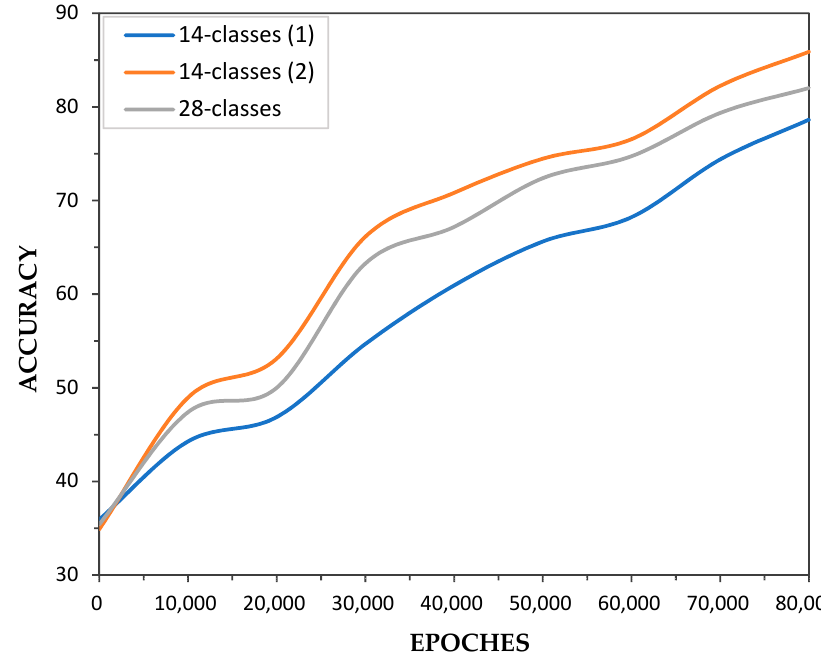
Figure 6. The accuracy curve of our method for 14-classes and 28-classes in the DHGD dataset. Table 2. Comparison results between long short-term memory (LSTM) and gesture recognition using an enhanced network (GREN) networks based on the DHGD